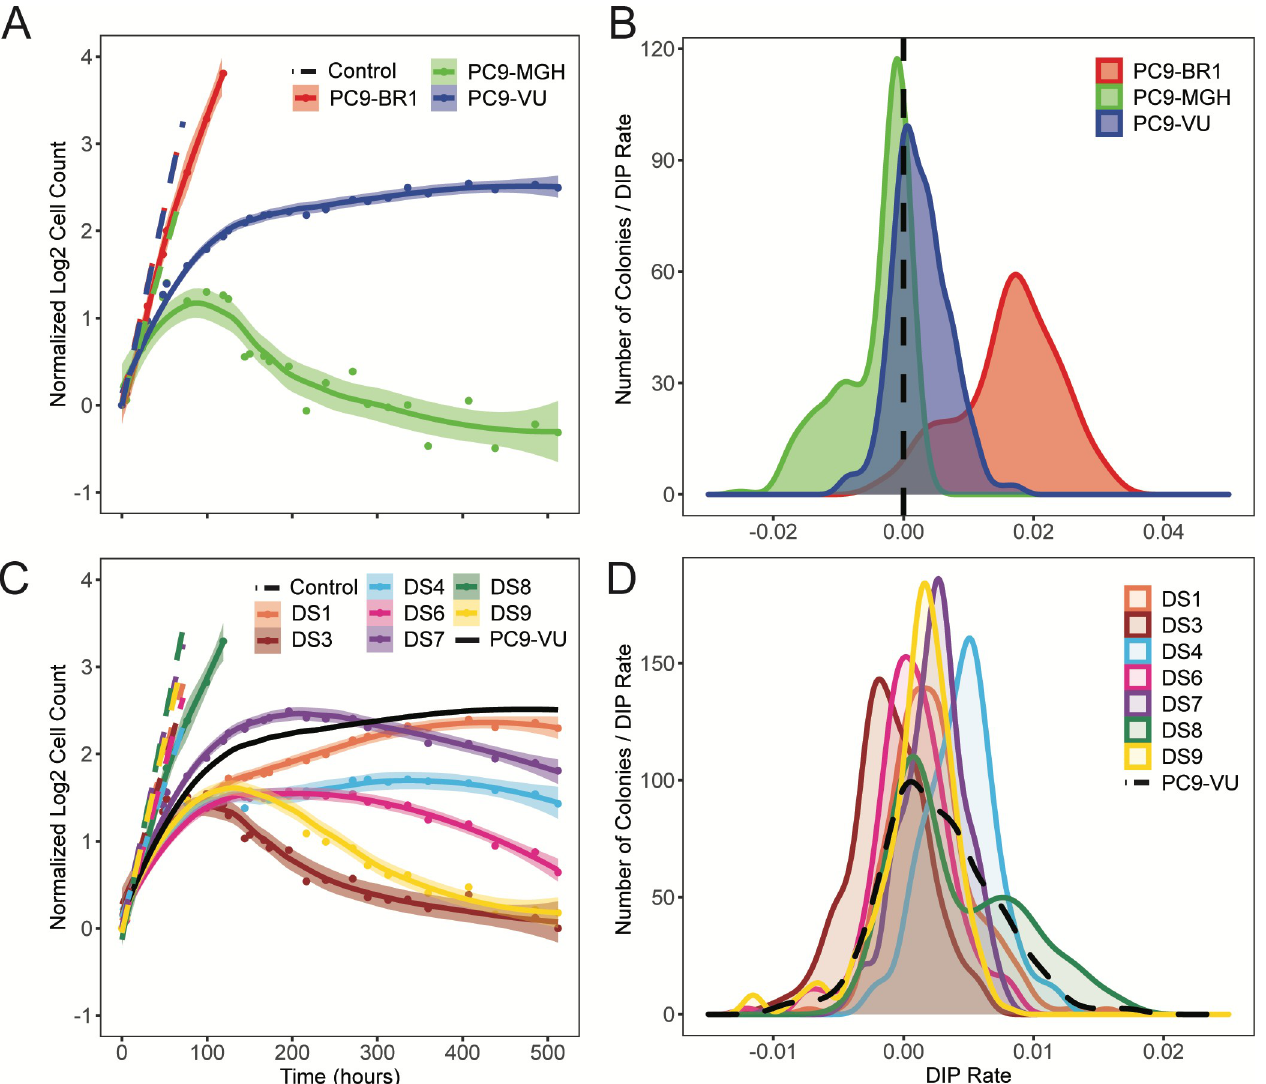
Fig 2. Phenotypic differences among PC9 cell line versions and discrete sublines quantified in terms of drug response. (A) Population growth curves for 3 cell line versions treated with 3 μ M erlotinib for approximately 3 weeks, plus vehicle (DMSO) control. (B) DIP rate distributions compiled from single-colony growth trajectories under erlotinib treatment (3 μ M) in a cFP assay. DIP rates are calculated from the growth curves 48 h postdrug addition to the end of the experiment. Dashed black lines signify zero DIP rate, for visual orientation. (C) Seven DS derived from PC9-VU were treated with 3 μ M erlotinib for 3 weeks, along with vehicle control. Parental PC9-VU is included for reference. (D) DIP rate distributions from a cFP assay of the sublines in 3 μ M erlotinib. Parental PC9-VU is included for reference. In A and C, dots are the means of 6 experimental replicates at each time point; solid lines are best fits to the drug response trajectories with point-wise 95% confidence intervals. In B and D, DIP rate distributions are plotted as kernel density estimates. The data underlying this figure can be found in github.com/QuLab-VU/GES_2021. cFP, clonal fractional proliferation; DIP, drug-induced proliferation; DS, discrete subline.